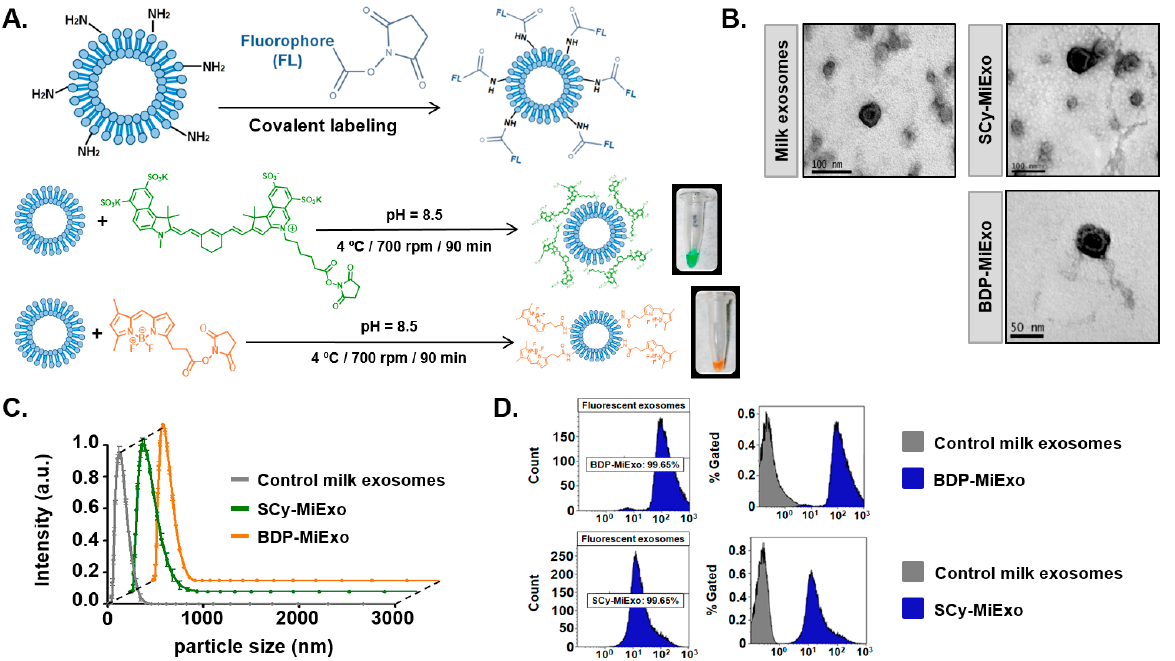
Figure 1. Optical labeling and physicochemical characterization of control and fluorescence-labeled milk exosomes (MiExo). ( A ) Chemical strategies for labeling exosomes with Bodipy FL (BDP-FL, orange) and sulfo-cyanine 7.5 (SCy 7.5, green), and the resulting fluorescently labeled exosomes in dilution fluids. ( B ) Transmission electron microscope images for morphological evaluations of exosomes. ( C ) Size distributions of nanovesicles, evaluated with dynamic light scattering. Data are expressed as the mean ± standard deviation; ( D ) Flow cytometry results show the abundances of control exosomes (grey) and fluorescent nano-probes (blue). SCy MiExo: SCy 7.5-labeled milk exosomes; BDP-MiExo: BDP-FL-labeled milk exosomes .